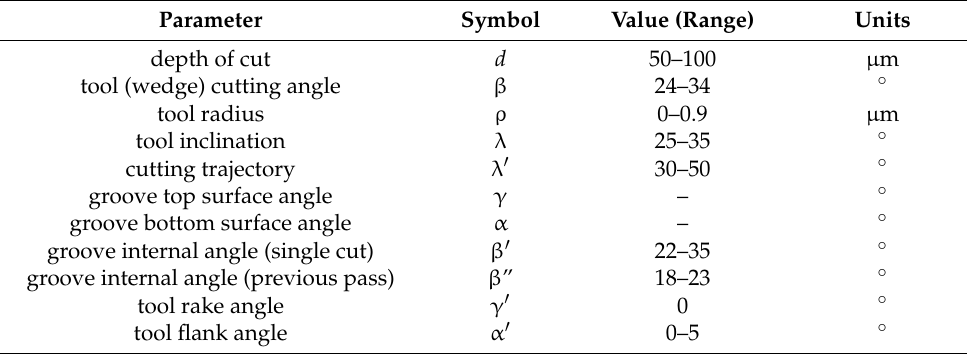
Table 1. Experimental and simulated conditions according to the symbols in Figure